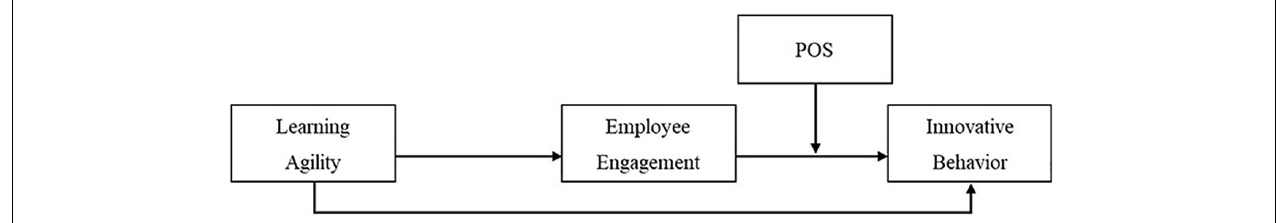
FIGURE 1 | Theoretical moderated mediation